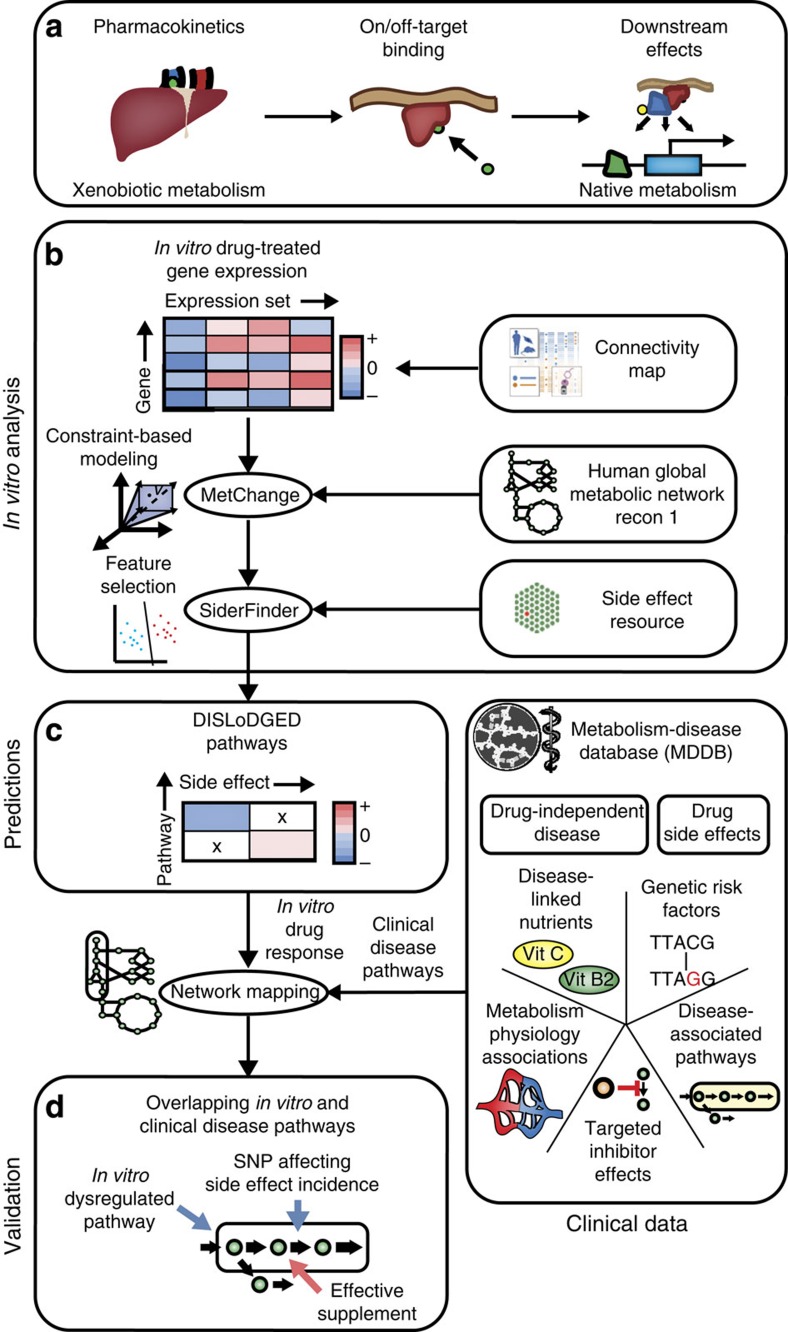
Overview and workflow used in this study.(a) Studies examining side effect pathogenesis focus primarily on drug pharmacokinetics, involving drug transport and clearance, and drug binding in terms of on and off target-binding events. This study examines potential pathogenic mechanisms related to transcriptional changes downstream of clearance and binding events. (b) Drug-treated gene expression profiles from the Connectivity Map database are analysed in the context of the metabolic network reconstruction Recon 1 using constraint-based modelling to identify drug-induced pathway expression changes. Drug-induced metabolic pathway expression changes are analysed in terms of drug side effects from the Side Effect Resource (SIDER) using a feature selection genetic algorithm to determine metabolic pathway perturbations conserved in particular side effects, termed DISLoDGED pathways. (c) A new database, the Metabolism Disease Database (MDDB), was generated by manual curation of literature to establish links between altered metabolic pathway function and pathologies, and this database was used to analyse DISLoDGED metabolic pathways. (d) Five candidate causal mechanisms for metabolic changes in side effect pathogenesis (listed in the MDDB panel) are assessed in a large-scale manner by comparing these in vitro perturbations to clinical data linking particular metabolic pathways to disease.